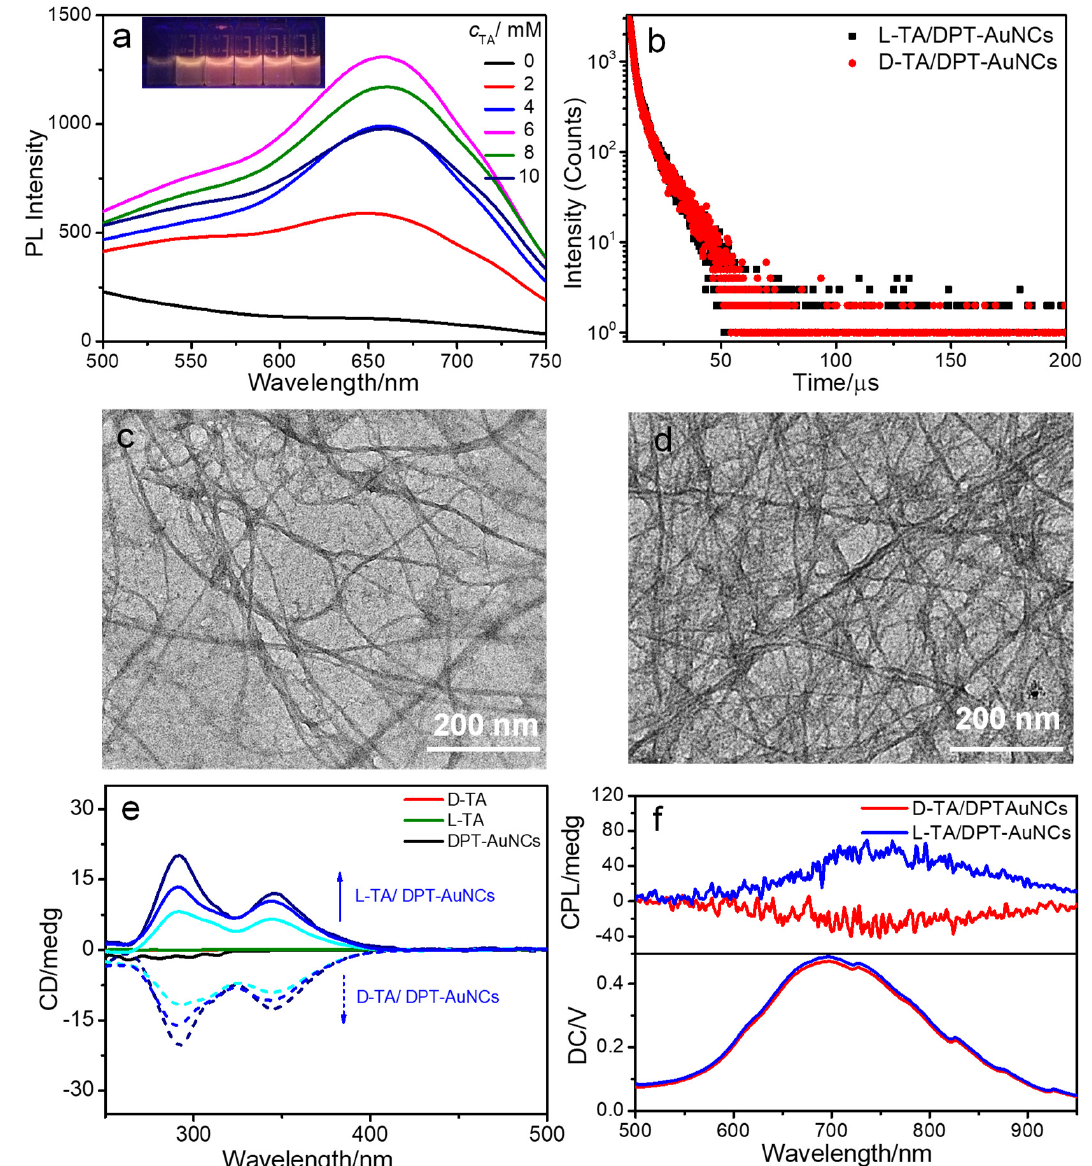
Figure 4. ( a ) QY of DPT-AuNCs with different concentrations of D-TA (insets are photos of samples under handhold UV lamps with 365 nm). ( b ) PL decay traces of L-TA/DPT-AuNCs and D-TA/DPT- AuNCs. ( c , d ) TEM image of L-TA/DPT-AuNCs and D-TA/DPT-AuNCs. ( e ) CD spectra of L-TA, D-TA, DPT-AuNCs, L-TA/DPT-AuNCs and D-TA/DPT-AuNCs complex solution ( c TA = 2 mM, 4 mM, 6 mM successively). ( f ) CPL spectra of the L/D-TA/DPT-AuNCs enantiomers in the solution state. CPL-active materials with low g lum are limited in practical application. To achieve samples with higher g lum , ternary co-assembly of CA/TA/DPT-AuNCs was performed, based on the strong luminescent property of CA/DPT-AuNCs and the similar molecular structures of TA and CA. During the process, CD and CPL spectra were measured. Both the CD and CPL signals were positive. Firstly, with the addition of TA, CD signals were also observed at 250–400 nm in the case of CA/TA/DPT-AuNCs. Secondly, the CPL g lum of L-TA/CA/AuNCs and D-TA/CA/AuNCs mixture increased to 0.0436 and − 0.006 (Figure 5b) with 4.6-fold and 1.3-fold enlargements, respectively, compared with the binary TA/DPT-AuNCs. Thus, this co-assembly system not only built the CPL-active materials through achiral AuNCs, but also further amplified the CPL